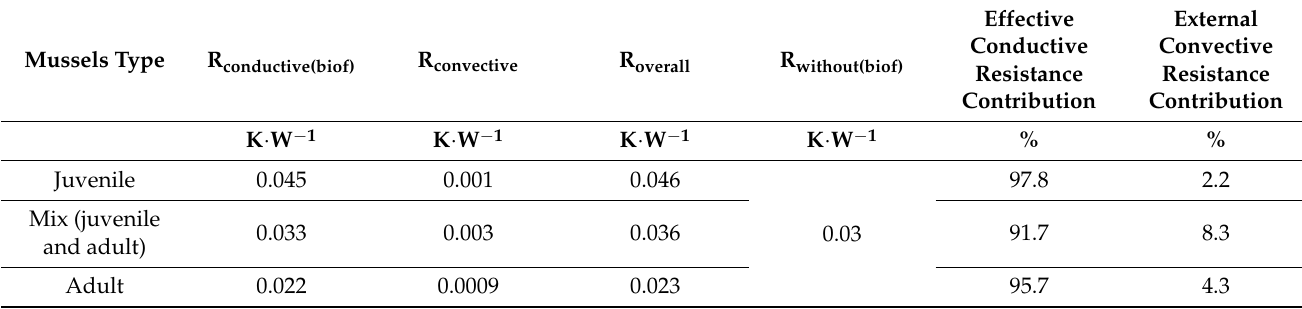
Table 5. Comparison between conductive and convective thermal resistances as a function of the ages of the mussels.